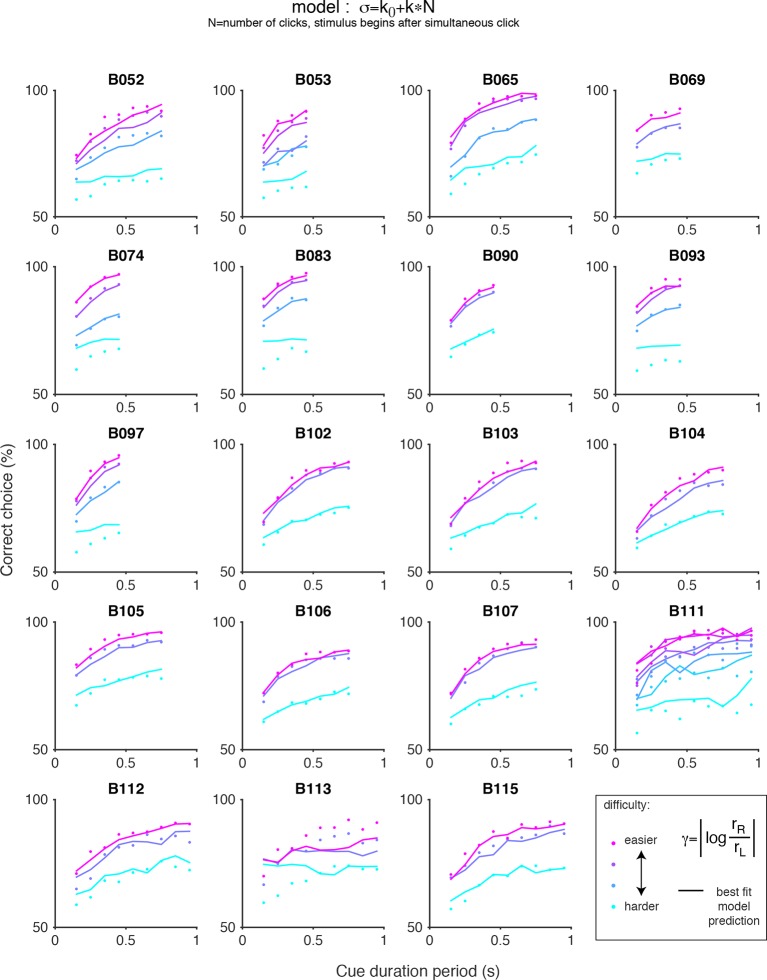
Chronometric plots for the auditory (clicks) data and predictions of scalar variability with an offset.Each panel shows the performance of an individual rat on the auditory accumulation task as a function of the duration of the cue period. Colored dots indicate the data and colored lines indicate the prediction of scalar variability with an offset: σ = k0+kN, where N is the number of clicks after the simultaneous click. Color indicates trial difficulty, parameterized by γ, the log of the ratio of the rates of the clicks on each side. Across all animals, performance increases as a function of cue duration for a fixed γ (colored dots). Whereas pure scalar variability predicts flat psychometric function (see Figure 3—figure supplement 6), inclusion of an offset term captures increased performance with cue duration.